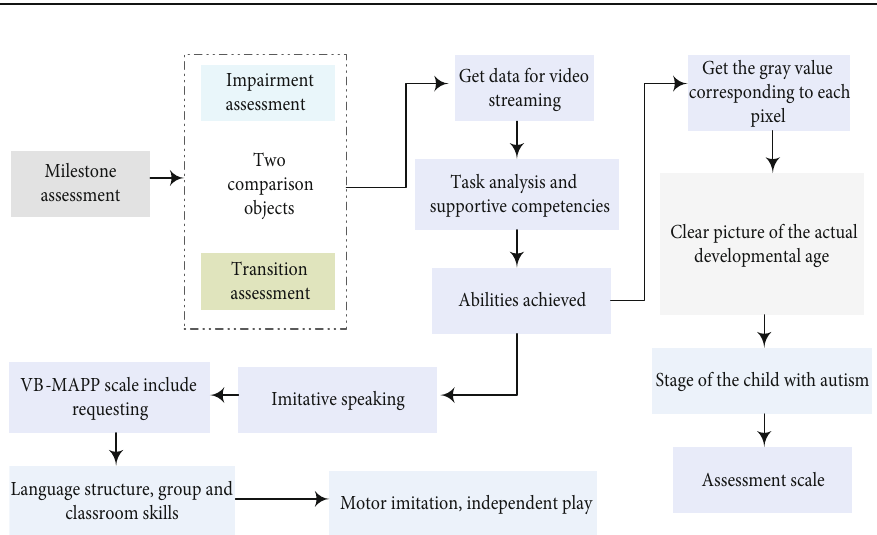
Figure 1: Verbal behavior milestone